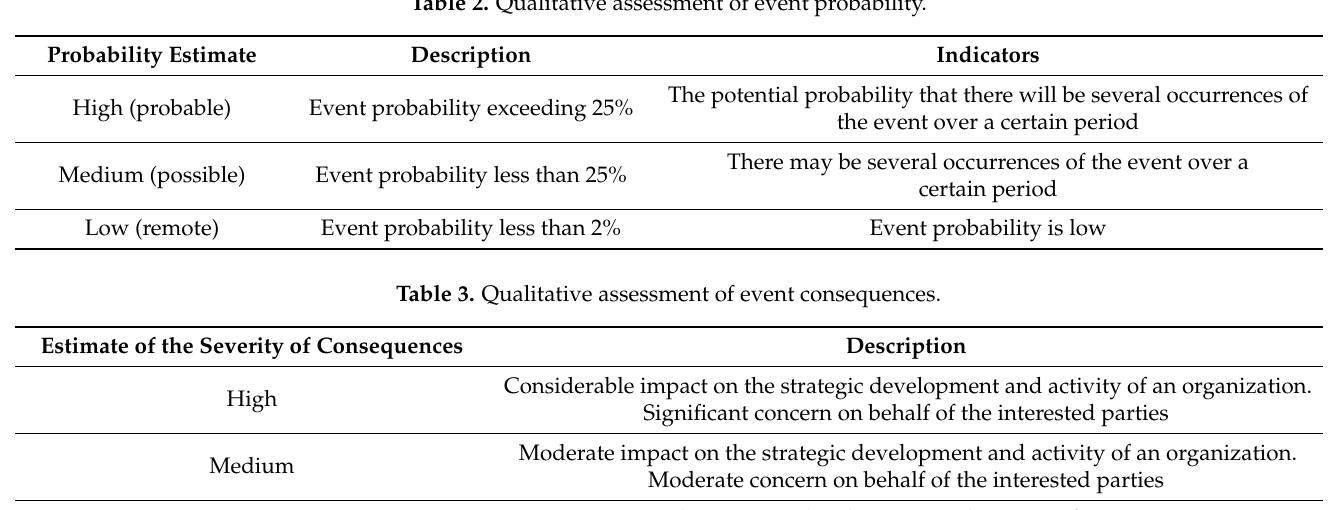
Table 2. Qualitative assessment of event probability.